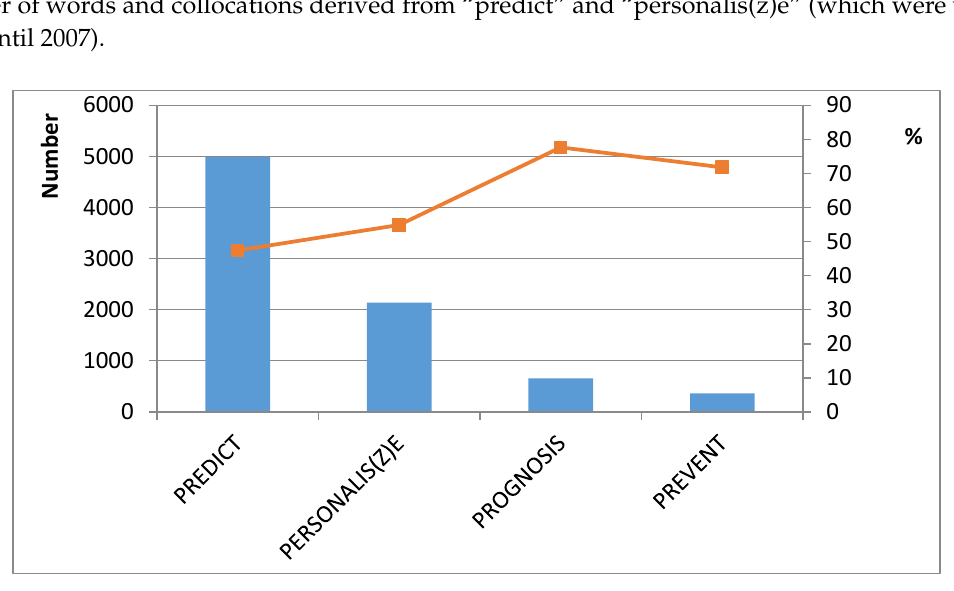
Figure 2. The number and relative growth of derivatives and collocations with the root words “ prognosis ” , “ prevent ” , “ predict ” , and “ personalis(z)e ” since 2007.